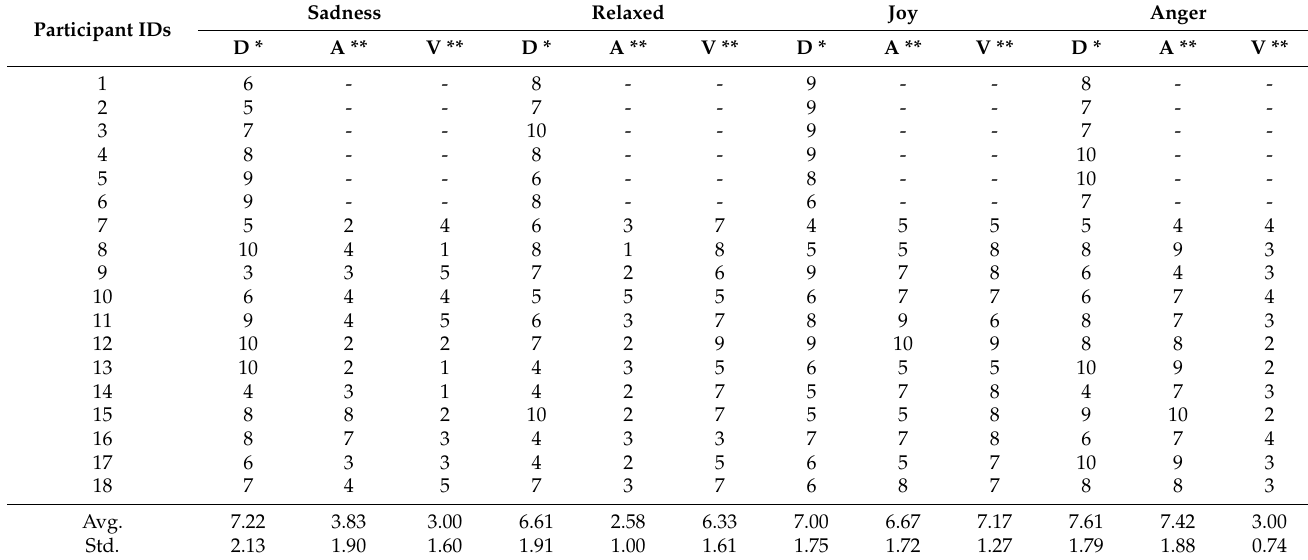
Table 8. Participants’ responses on the degree of emotional